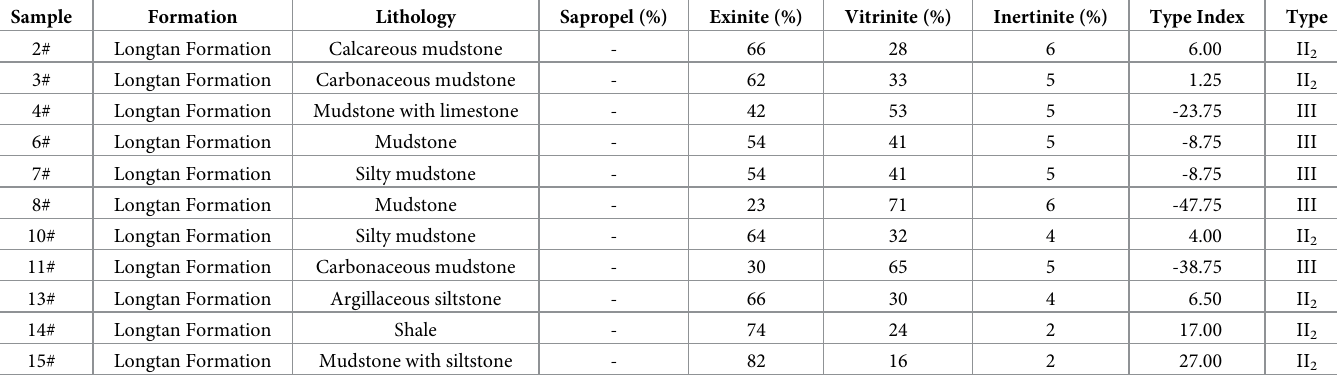
Table 2. Analysis results for kerogen type of Longtan Formation